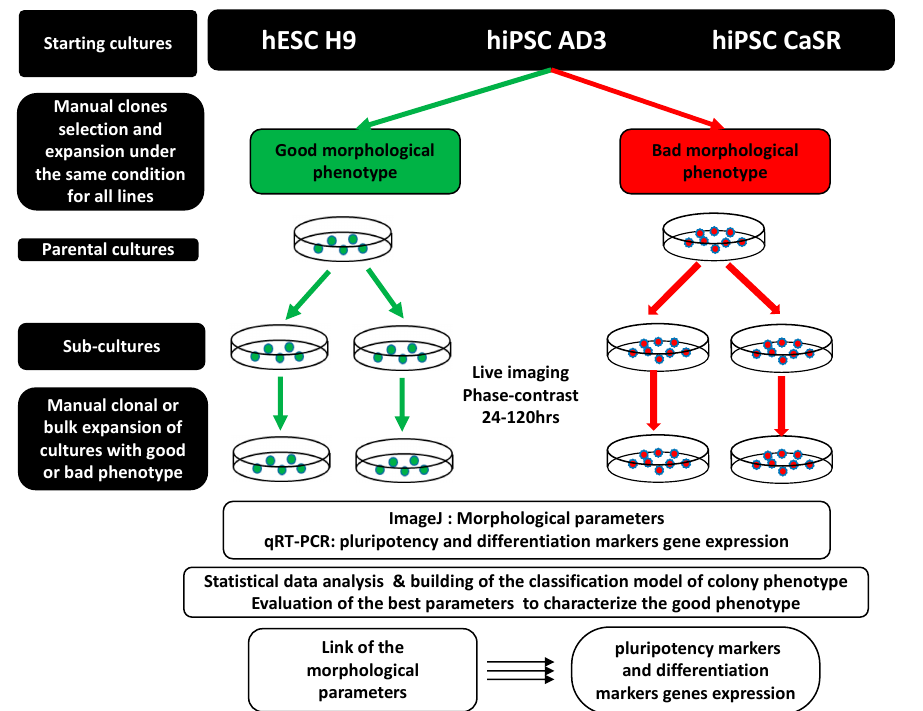
Figure 2. Schematic representation of the experimental design. Schematic representation of the experimental regime, in which hESC line H9 and two hiPSC lines (AD3 and CaSR) were cultured for an extended period under the same culture conditions. Stock cultures of all three lines were propagated manually by separately selecting cultures with good and bad colony morphology, and phase-contrast images were recorded for colonies of different morphological phenotype from 24 to 120 h in the early, middle, and late passages. Each colony of good or bad phenotype was then recloned manually to generate clonal subcultures. Parent cultures propagated via bulk expansion were further cultured under bulk conditions to generate nonclonal cohorts. At the end of the expansion period, cultures were propagated again manually or bulk-expanded to obtain cultures of good and bad morphological phenotypes from which morphological parameters (phase- contrast/ImageJ) and genetic material were extracted for gene expression via qRT-PCR analyses.